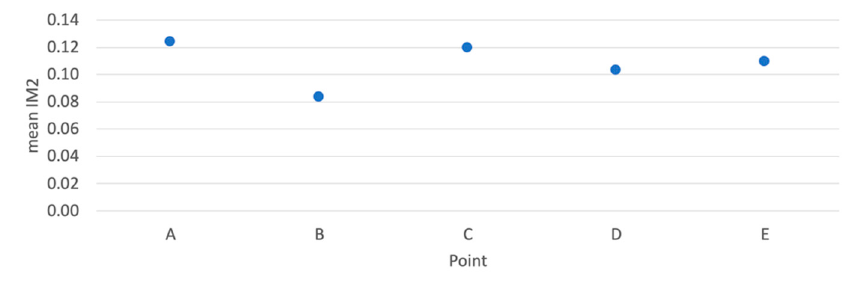
Figure 16. Mean IM 2 for each measurement point on the lower deck.